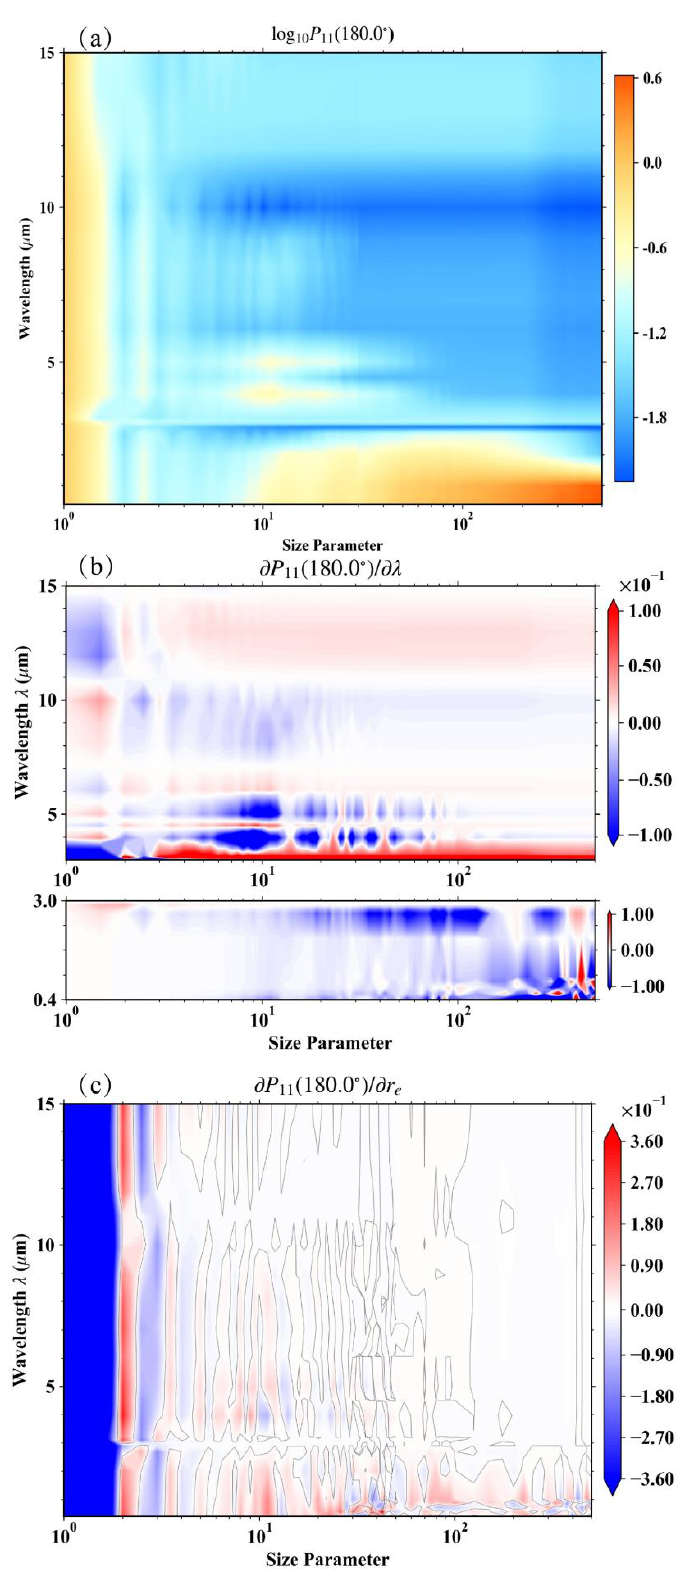
Figure 9. The exact backward scattering ( P 11 (180 ◦ )) ( a ) and its partial derivatives with respect to wavelength ( b ) and effective radius ( c ) for size parameters of 1–500 and wavelengths of 0.4–15 µ m. The dashed line in (c) represents the division of positive and negative